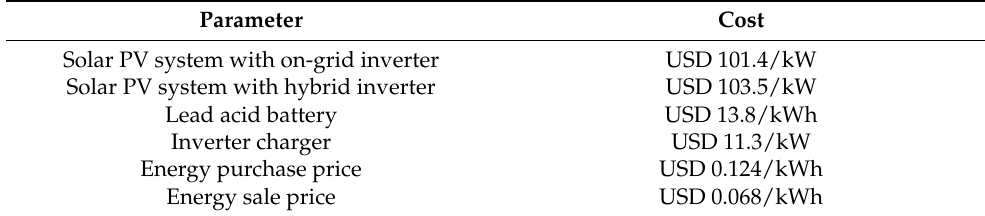
Table 3. Base investment costs, annualized with a 3% discount rate. Source: